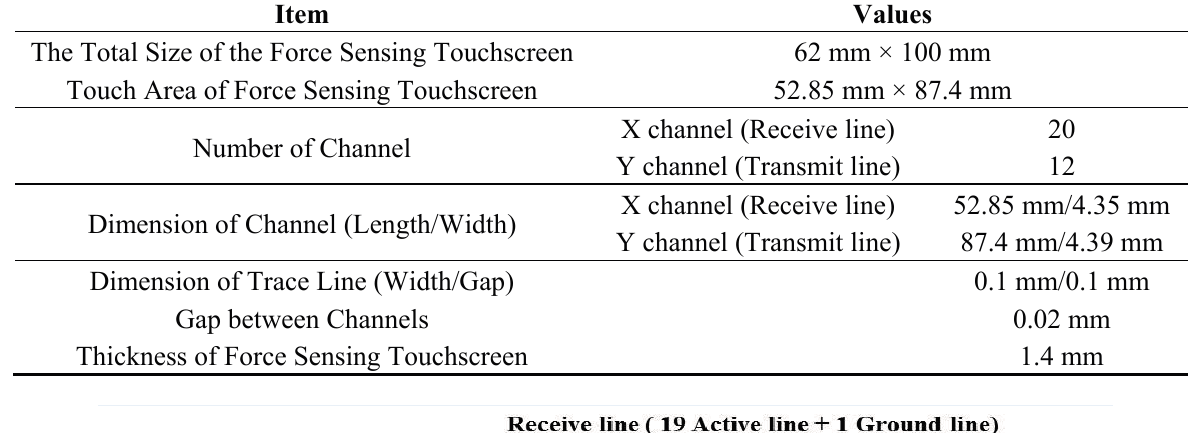
Table 1. Design parameters of force sensing touchscreen.